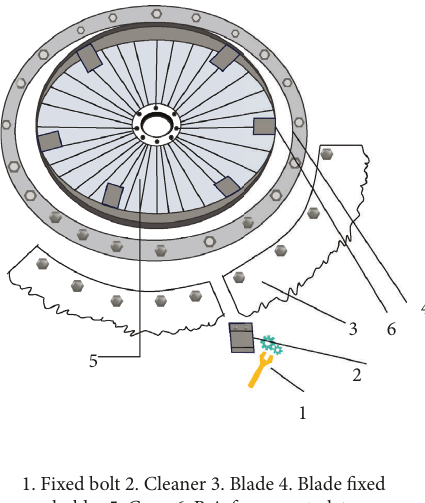
Figure 3: Exploded view of the saw